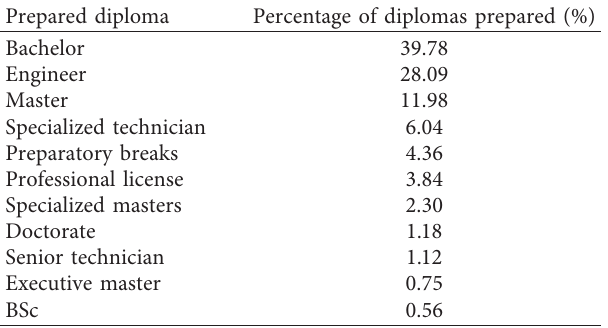
Table 9: Distribution of diplomas prepared by students.